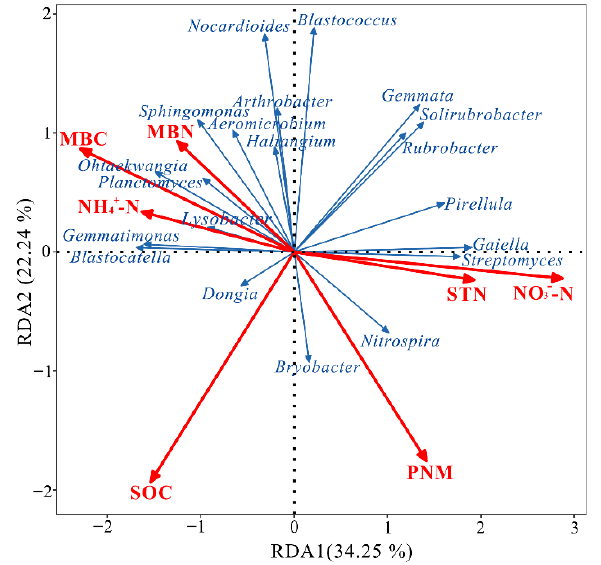
Figure 4. RDA among the higher levels of bacteria (top 20) and soil factors under different mulching treatments.